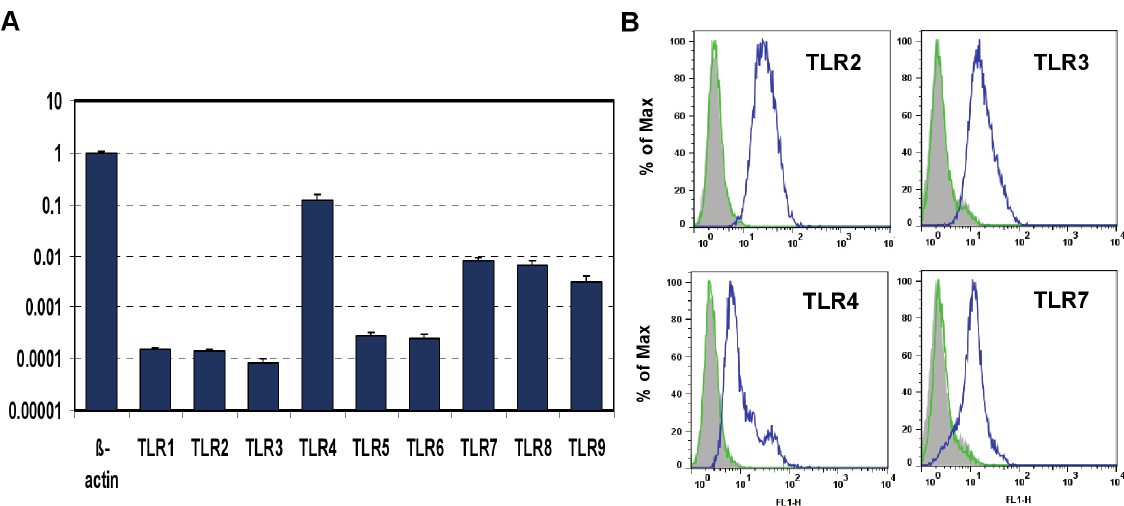
Figure 1. Expression of Toll-like Receptors (TLRs) in J774A.1 murine macrophages. ( A ) J774A.1 cells were profiled for TLR1-9 gene expression by quantitative real-time polymerase chain reaction (PCR) using predeveloped TaqMan Gene Expression assays (AppliedBiosystems). Expression levels of target genes were normalized to the housekeeping gene β -actin ( Δ Ct). Relative gene expression values were calculated based on the ΔΔ Ct method, with data for all samples analyzed against the mean value of four replicates; ( B ) Expression of cell surface TLR2 and TLR4, and intracellular TLR3 and TLR7 in naïve J774A.1 cells was analyzed by flow cytometry (FACS) using standard protocols. Empty, dashed and blue histograms represent only cells (no antibodies), isotype antibody controls, and TLR expression in 774A.1 cells,